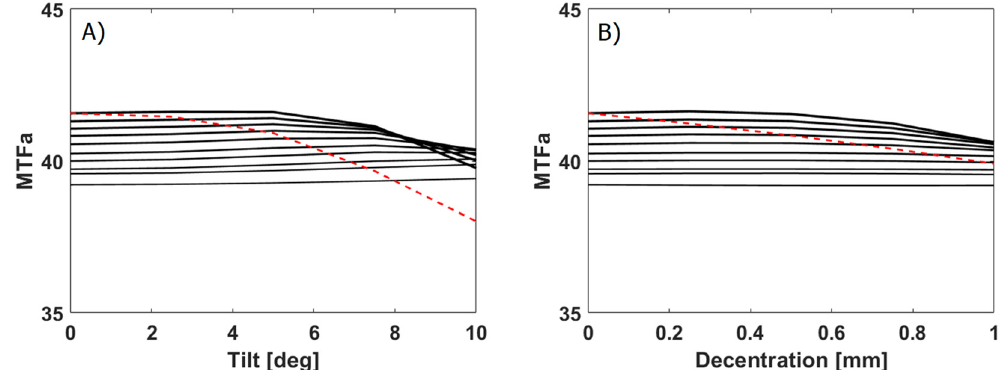
Figure 1. The impact of isolated tilt ( A ) and decentration ( B ). The solid black lines refer to 10 sulcus-fixated IOLs, with the nominal power from 1 D (bottom line) to 10 D (top line). The dashed red line indicates the 20 D capsular fixation lens.